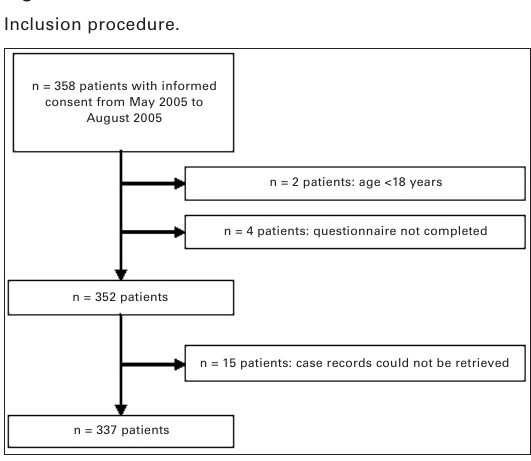
Inclusion procedure.